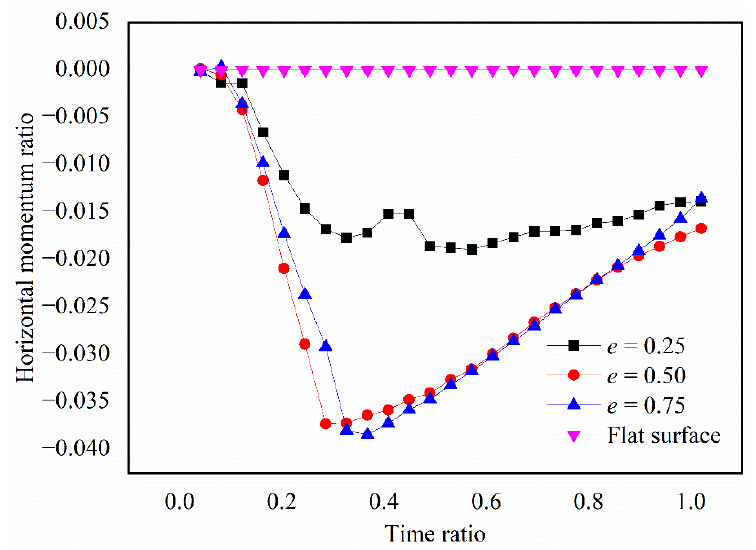
Figure 12. Variations of the horizontal momentum (normalized by the initial momentum at droplet impact) with time (normalized by capillary time).